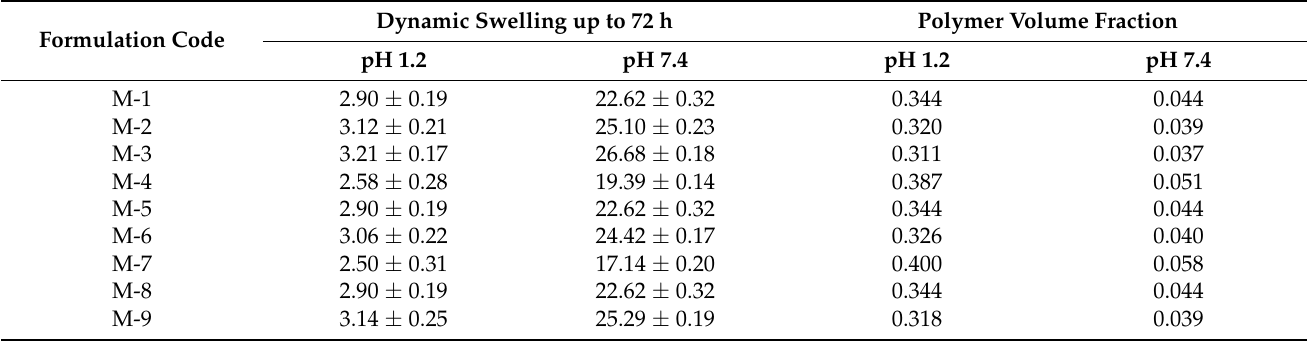
Table 3. Dynamic swelling and polymer volume fraction of CS/Al-g-pAa